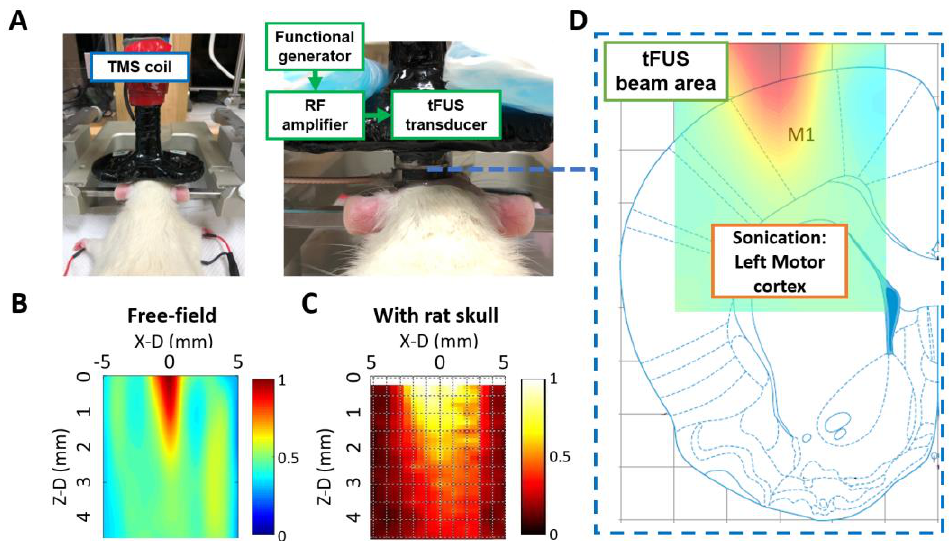
Figure 7. ( A ) The Center of the transcranial magnetic stimulation (TMS) coil and transcranial focused ultrasound (tFUS) transducer are positioned and focused on the motor cortex of the left hemisphere. ( B ) Characterization of the FUS pressure fields in sagittal (Y–Z plane) scans of ultrasound pressure distribution using a hydrophone-based ultrasound field mapping system. ( C ) Characterization of the tFUS pressure fields in sagittal (Y–Z plane) scans. ( D ) Conceptual schematic of the topographical sonication depth targeting the motor cortex area [56].